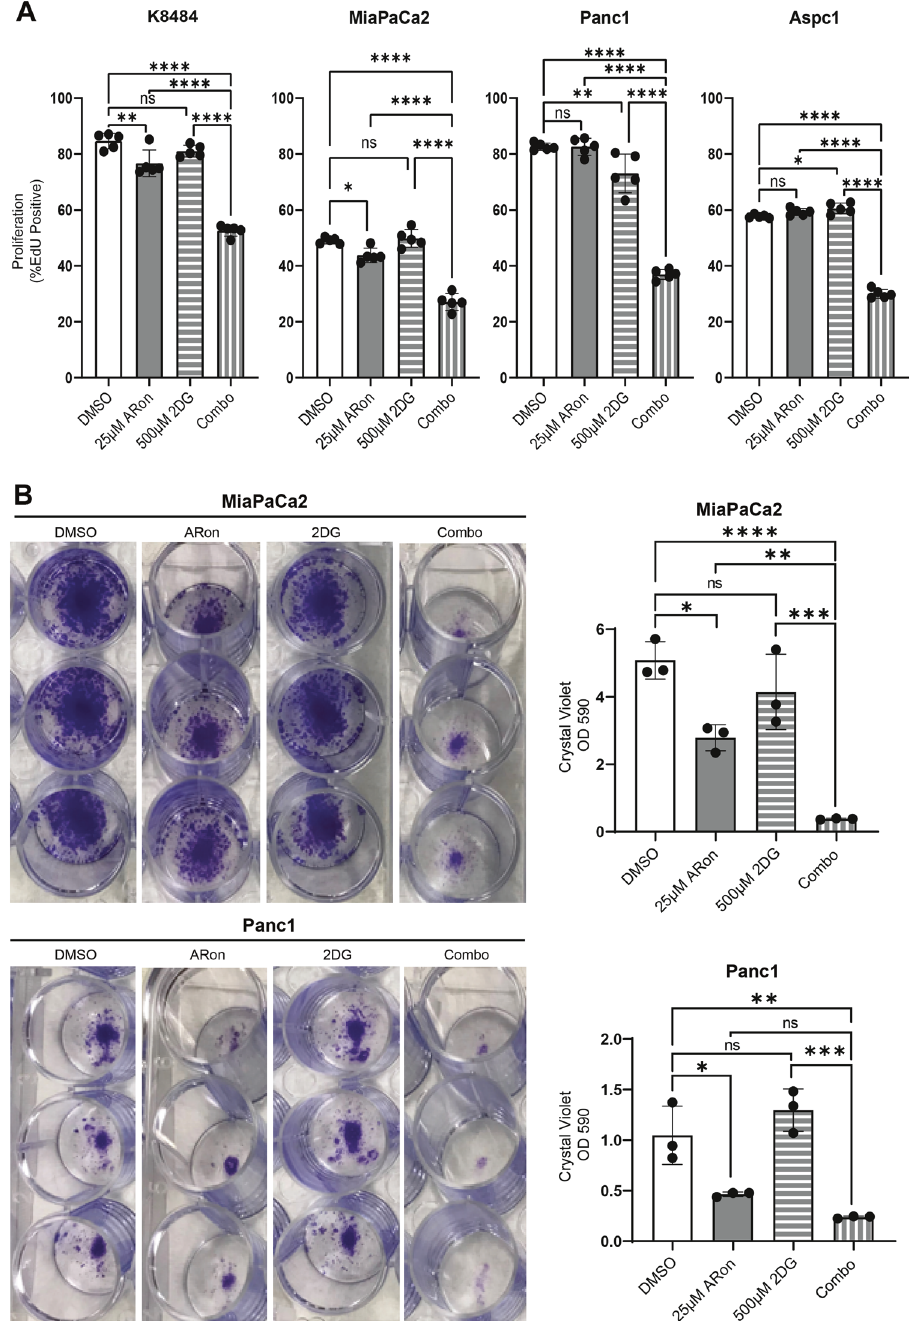
Fig. 5 Disruption of glycolysis enhances AdipoRon-mediated growth inhibition. Indicated cells were treated alone or in combination with AdipoRon (25 µM) and/or the glycolysis inhibitor 2DG for 24 h and then proliferation was measured by EdU incorporation ( A , n = 5). MiaPaCa2 and Panc1 cells were pulse-treated with AdipoRon alone or in combination with 2DG for 36 h, allowed to recover, and assessed for colony formation 7 days later by crystal violet staining ( B , n = 3). One-way ANOVA; error bars, SD; * P <